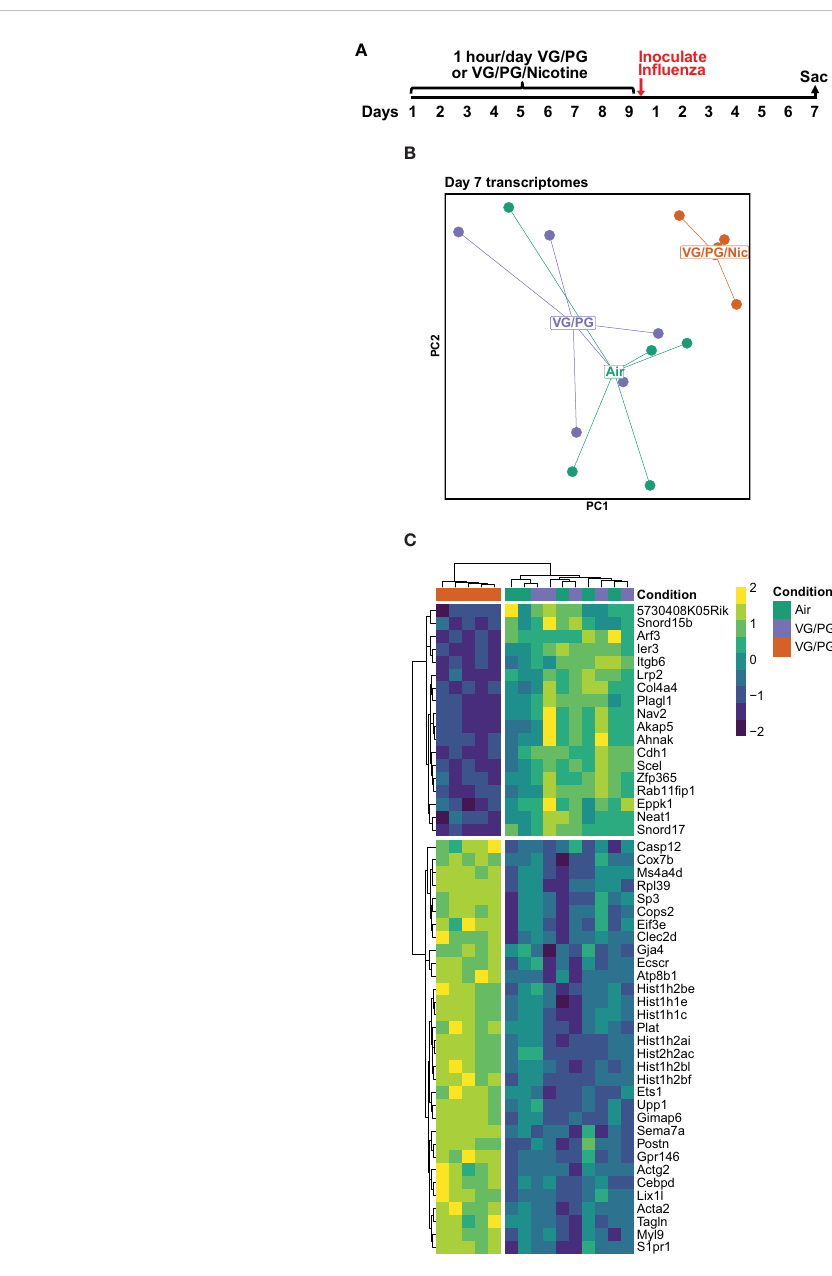
FIGURE 6 Pulmonary gene expression during in fl uenza infection is shifted by prior nicotine exposure. (A) Timeline of the experiment. Seven days after in fl uenza inoculation, mice were sacri fi ced to collect whole lungs for RNA extraction. (B) Principal components (PC1 and PC2) analysis of murine lung gene expression after 7 days of infection with in fl uenza following exposures to e-cigarette aerosols containing nicotine (VG/PG/Nic), only the carrier (VG/PG), or to air. (C) Heatmap of the top 50 differentially expressed genes by adjusted P value in the lungs from in fl uenza-infected mice exposed to aerosolized VG/PG/Nic compared to those exposed to VG/PG or to air. Each data point represents one